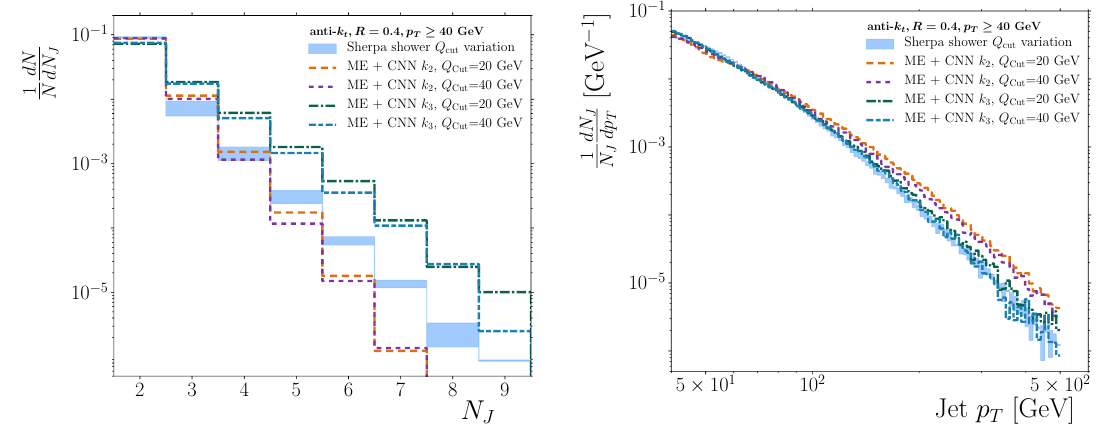
Figure 10 . Jet multiplicity (left) and p T (right) distributions compared for merging scales of 20 GeV and 40 GeV for models k 2 and k 3 . The merging scale variation using Sherpa’s native shower with merging scales of 20 and 40 GeV is shown as the shaded blue